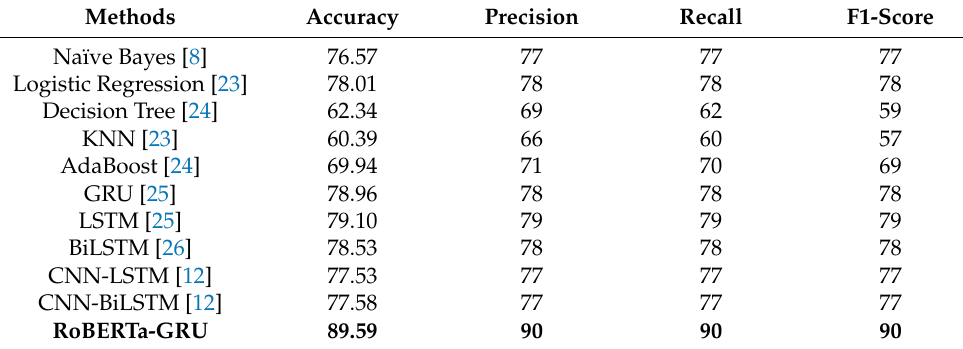
Table 8. The comparison results on the Sentiment140